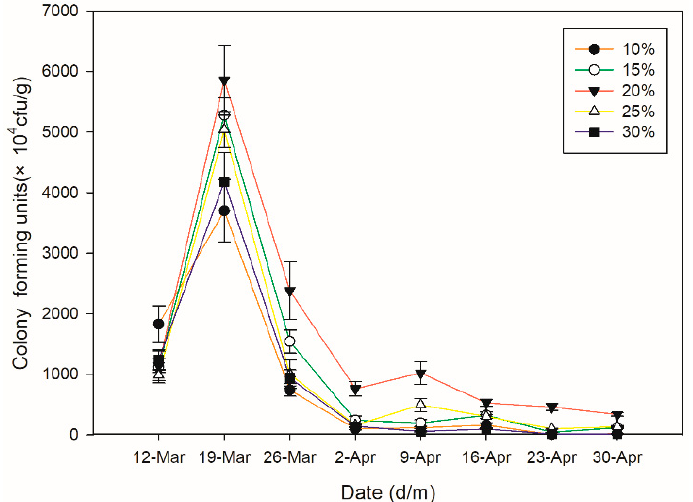
Figure 3. Effects of the soil moisture content on the survival and multiplication of Beauveria bassiana. Bars denote standard errors of the means. The first sample date shown is one week after inoculation of the soil with B. bassiana -impregnated granules.